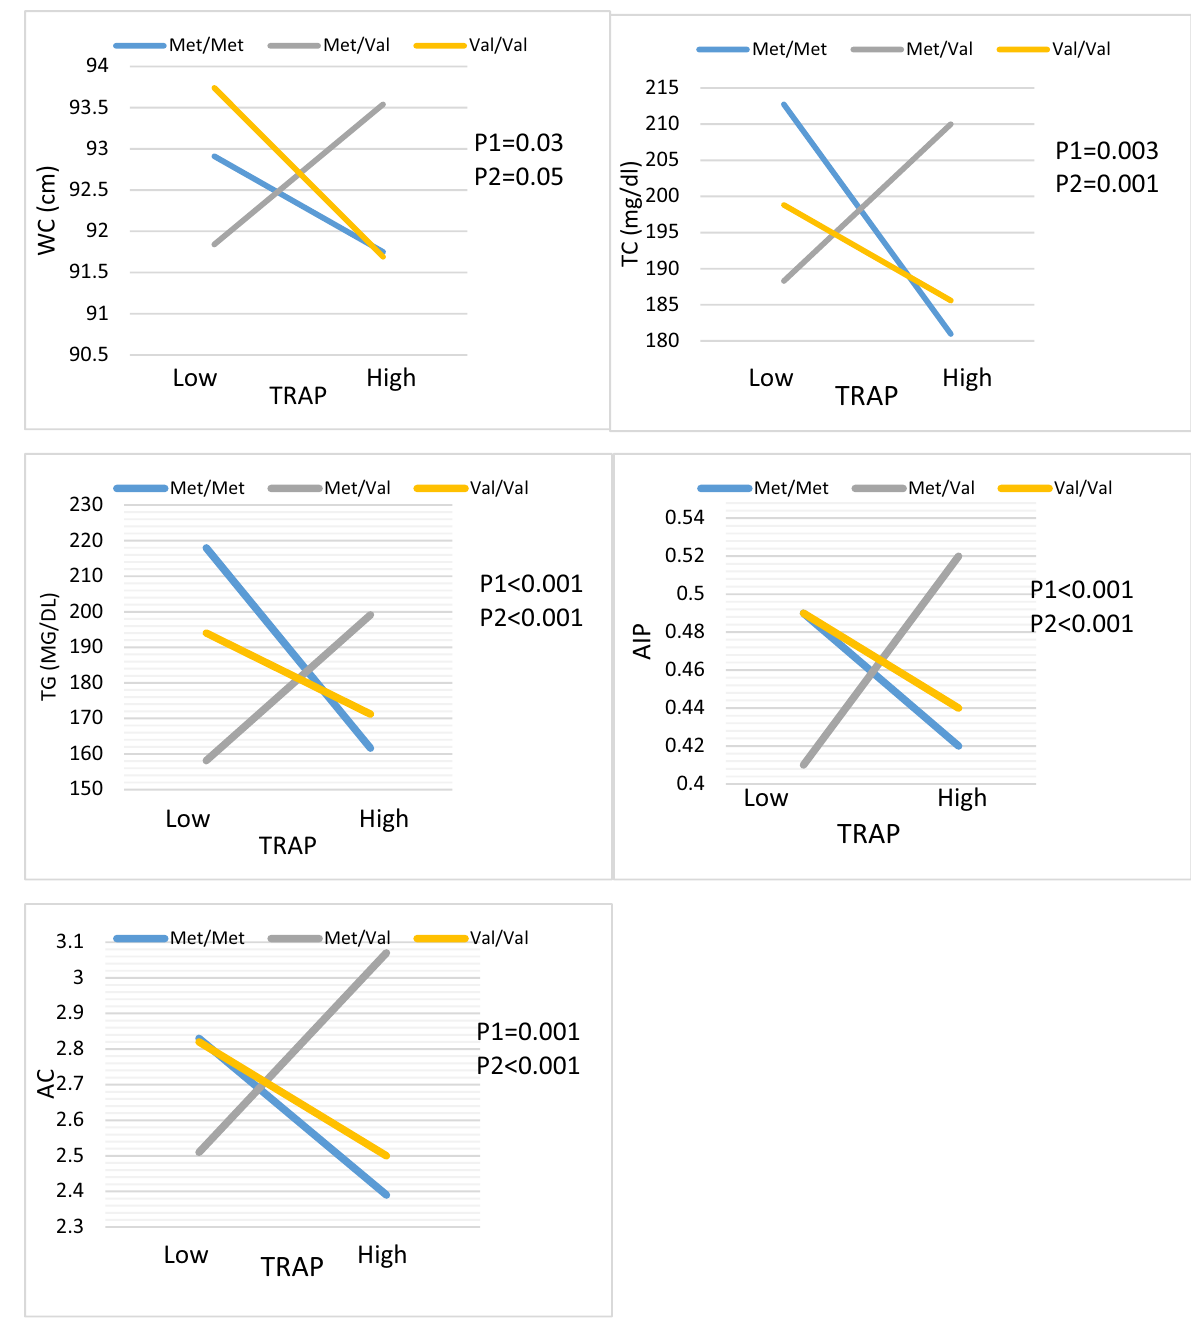
Figure 4. Interaction between the BDNF Val66Met polymorphism and DTAC (TRAP) intake with regard to TG, HDL, AIP and AC according to the median DTAC, the participants were dichotomized into low and high categories. P 1 = P value with unadjusted (crude) model, P 2 = P value with adjustments for potential confounding factors including (Age, physical activity, sex, smoking, alcohol, energy intake, lipid, and glucose- lowering medicines, and family history of